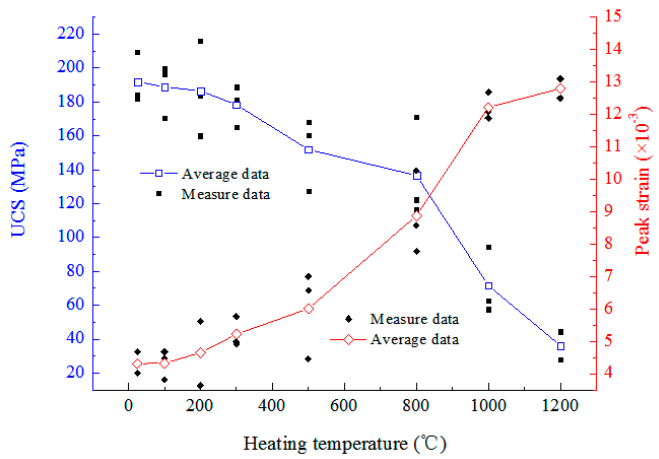
Figure 13. Variation of uniaxial compressive strength (UCS) and peak strain of the granite samples with heating temperature.